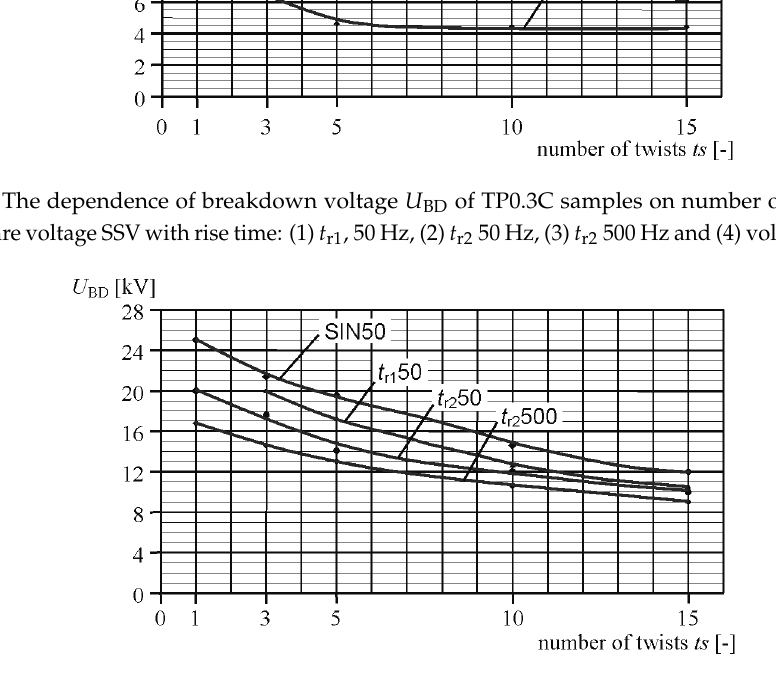
Figure 8. The dependence of breakdown voltage U BD of TP0.8CC samples on number of twists ts at semi-square voltage SSV with rise time: t r1 , (1) 50 Hz, (2) t r2 50 Hz, (3) t r2 500 Hz and (4) voltage VSIN50.